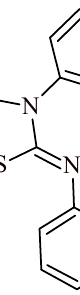
Figure 6. The structure of 3-(pyridin-2-yl)-2-(pyridine-2-ylimino)thiazolidin-4-one (PPIT). Verma et al. reported that Compound 11 (Figure 7) demonstrated excellent radical scavenging activity (78.83% of inhibition at concentration 100 µg/mL). The evaluation was carried out by the DPPH test [25]. Compound 12 with indolyl-pyridine moiety in structure showed more potent radical scavenging activity than 11 (80.89%, 86.02%, 89.86% and 92.05 % at concentration 25, 50, 75 and 100 µg/mL, respectively) [26]. Figure 7. The structures of Compounds 11 and 12 . 2.2. Anticancer Activity Malignant neoplasms are diseases that occur commonly in our population and have a relatively high mortality rate. It is the second leading cause of death in developed coun- tries, after cardiovascular disease. For many years, both the morbidity and mortality rate from malignant neoplastic diseases have been increasing. Only in recent years this ten- dency is slowed down [27]. The background to this state of affairs is the change in the demographic structure of societies over the years as well as the exposure to carcinogens, not all recognized to this day. In Poland, there are 155,000 cases and 93,000 deaths annu- ally [28]. Vascular endothelial growth factor (VEGF) is a well-characterized pro-angiogenic factor, necessary for the formation of new blood vessels during both embryonic develop- ment and pathological conditions. Research conducted recently has indicated a new role of VEGF as a neurotrophic factor [29]. The 5-(4-Methoxybenzylidene)thiazolidin-2,4-dione derivatives ( 13a – 13e , 14 , 15 and 16a – 16f ) were tested for their activity against the HepG2, HCT116 and MCF-7 cell lines [30,31]. Among all tested derivatives (Figure 8), Compounds 16f , 16e , 16d and 16c showed the highest antiproliferative activity in the in vitro studies against HepG2, HCT116 and MCF-7 cell lines. Their IC 50 values were in the range of 5.1–22.08 µM. Compound 16f showed most potent activity. It inhibited proliferation of HepG2 (IC 50 = 6.19 ± 0.50 µM)